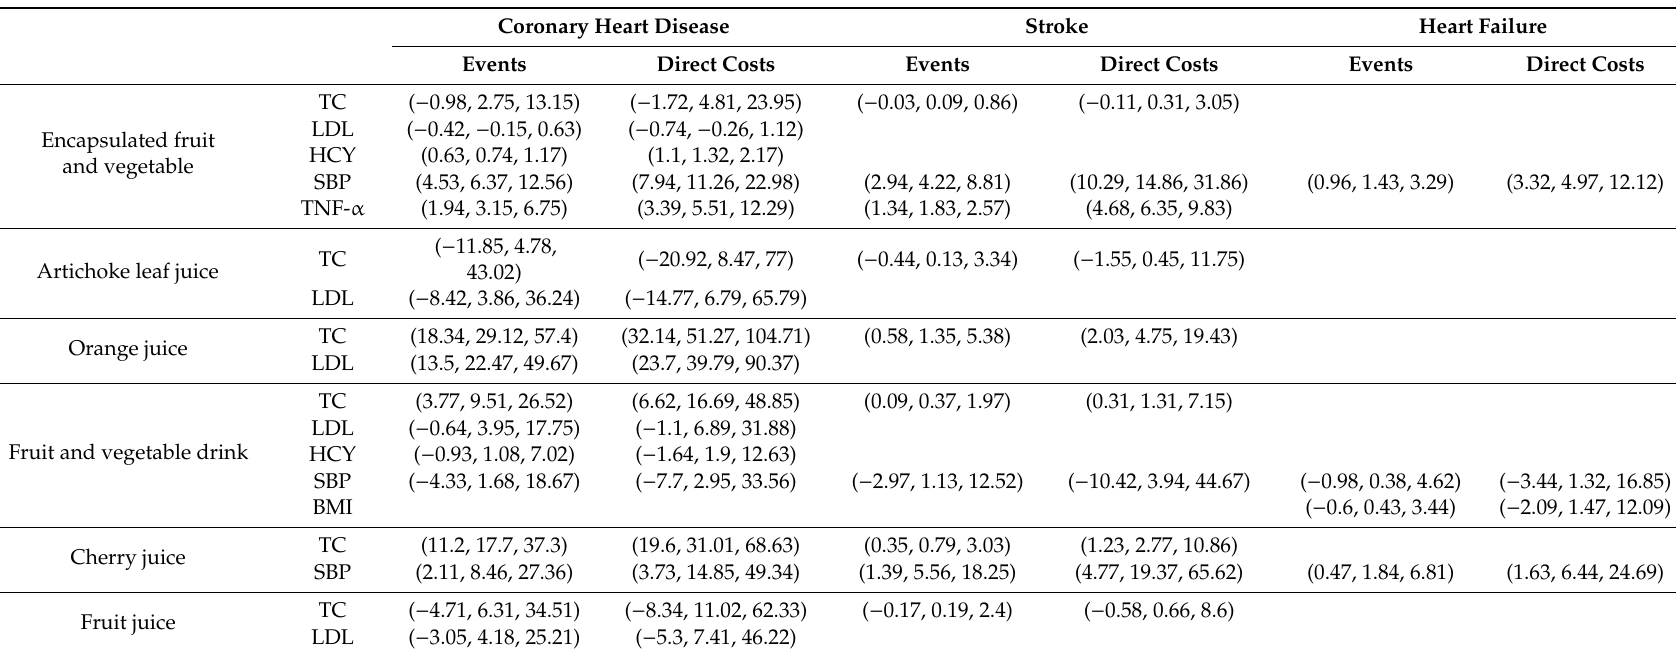
Table 6. Estimated e ff ect in terms of the absolute number of event reductions and their associated direct costs for di ff erent supplementation regimes in subjects with metabolic syndrome, projected in 2025. The median and the 95% credibility interval are reported. Reported events are expressed in millions of events (95% C.I. lower bound; median; 95% C.I. upper bound), while direct costs are expressed in billions of dollars (95% C.I. lower bound; median; 95% C.I. upper